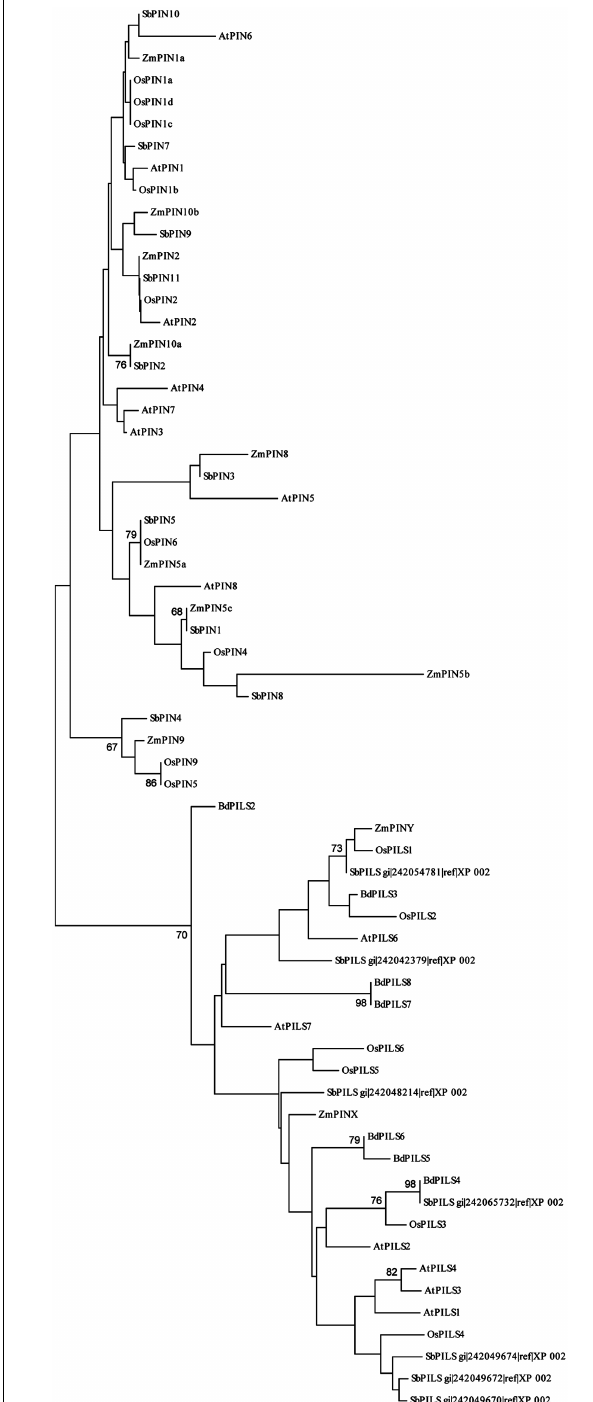
FIGURE 3 | Neighbor-joining sequence similarity analysis of the PIN and PILS proteins from Arabidopsis , rice, maize, sorghum, and Brachypodium . The unrooted tree shows the degree of sequence similarity among PIN and PILS proteins from Arabidopsis , rice, maize, sorghum, and Brachypodium . ZmPINX and ZmPINY present higher overall similarity to PILS rather than PIN proteins. Bootstrap values higher than 60 are indicated at each